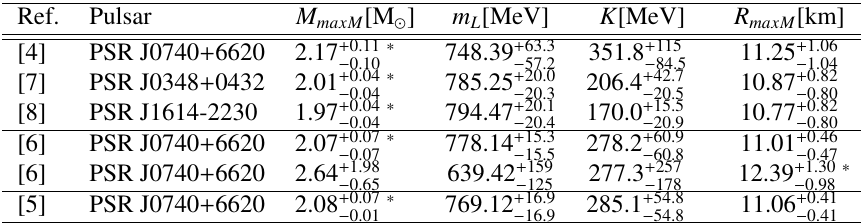
Table 1. The Landau mass, m L and compressiblity, K values evaluated via eqs. (4)-(7) from measured pulsar masses and radii data denoted by ’